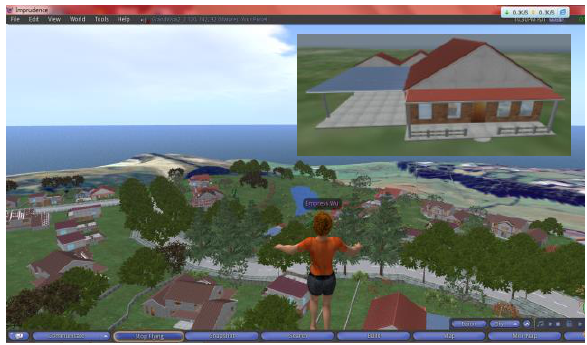
Figure 6. Overview of the finished virtual development. Inset: 3D virtual representation of bungalow in ‘sandpit’ virtual